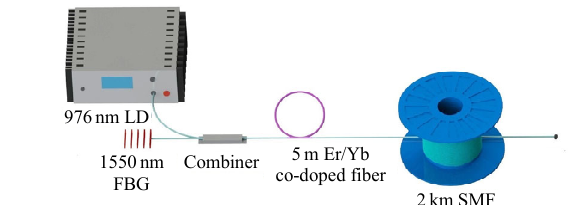
Fig. 1 Configuration of proposed EYRFL.